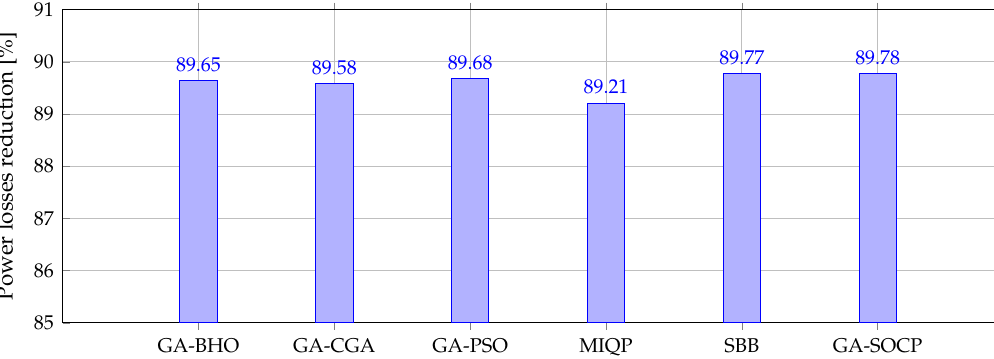
Figure 6. Percentage of improvement regarding power losses minimization in the 69-node test